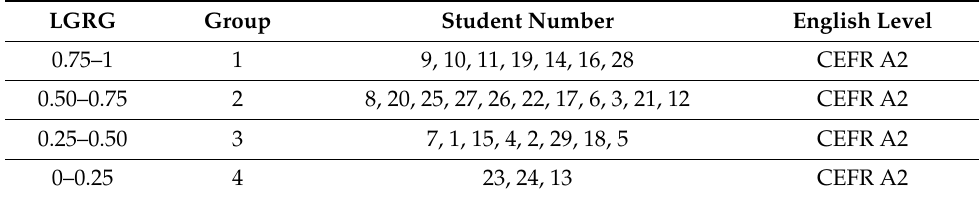
Table 4. Clustering students into